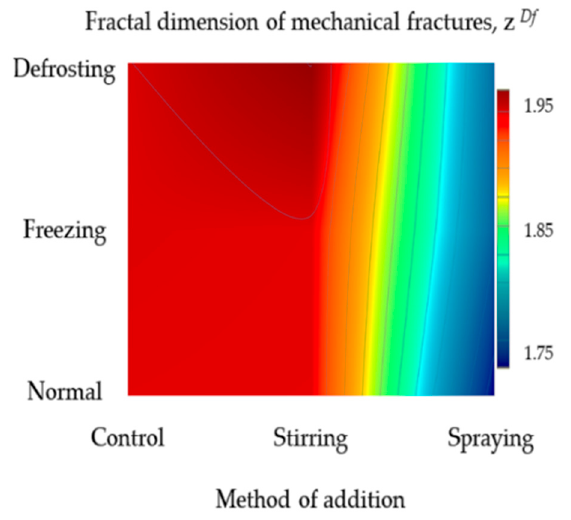
Figure 7. Two-dimensional fuzzy contour plotting for the interactive e ff ect of method of addition and storage condition on the fractal dimension of fractures by thermal shock on non-wood pellets from pressing residual biomass from distillation of cellulosic bioethanol with liquid-state food waste.